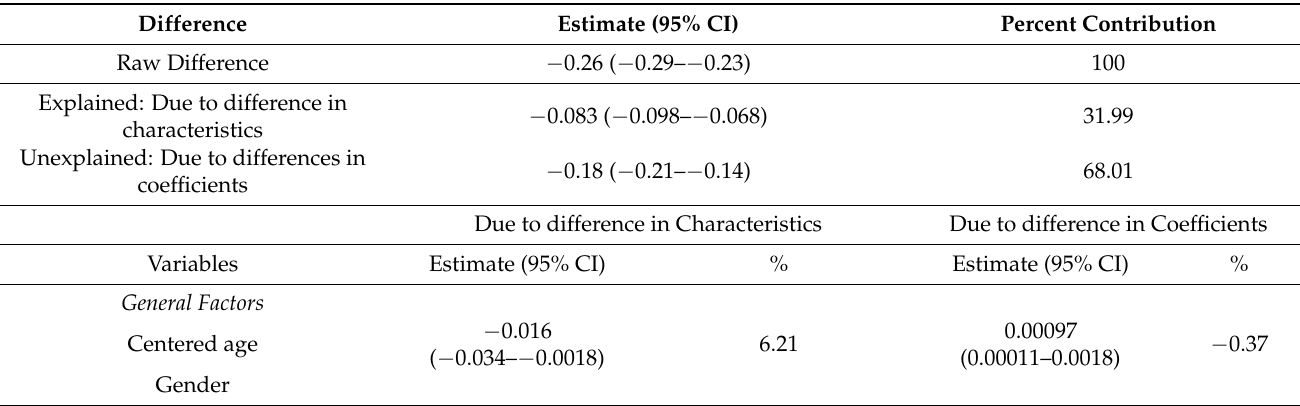
Table 5. Non-linear Blinder–Oaxaca decomposition of Black-non-Black gap in oral cancer checks, weighted on 8-year Mobile Exam Center (MEC) survey weights, N =